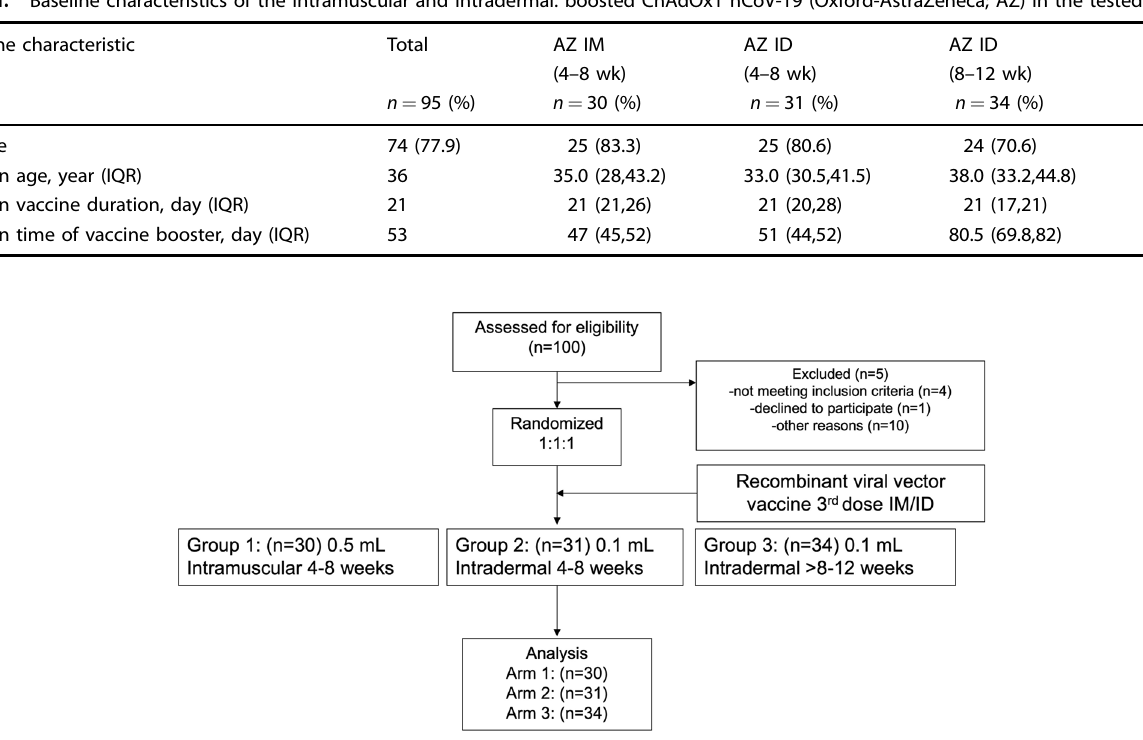
Fig. 1 CONSORT chart of study design and volunteer recruitment. Healthy volunteers who had been vaccinated with two doses of CoronaVac were recruited into the study. 94 participants were enrolled and randomised into 3 study groups. Group 1 participants were received a full dose of ChAdOx1 nCoV-19 intramuscularly. Group 2 and Group 3 volunteers were vaccinated intradermally with a fractional dose of the viral vector vaccine. The interval between completed primary series of CoronaVac and the booster was 4 – 8 weeks in Group 1 and 2 but was > 8 – 12 weeks in Group 3. ID intradermal, IM